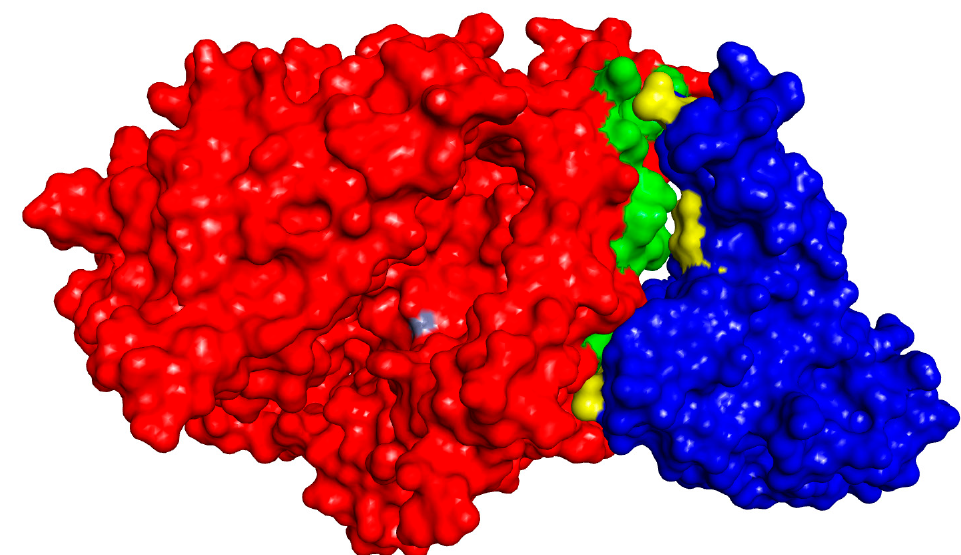
Figure 6. nCoV spike protein (blue) interacting with ACE2 (red). The yellow-green areas are showing the major attachment points between the two proteins. The grey area in ACE2 represents the zinc atom in the center of the active site.